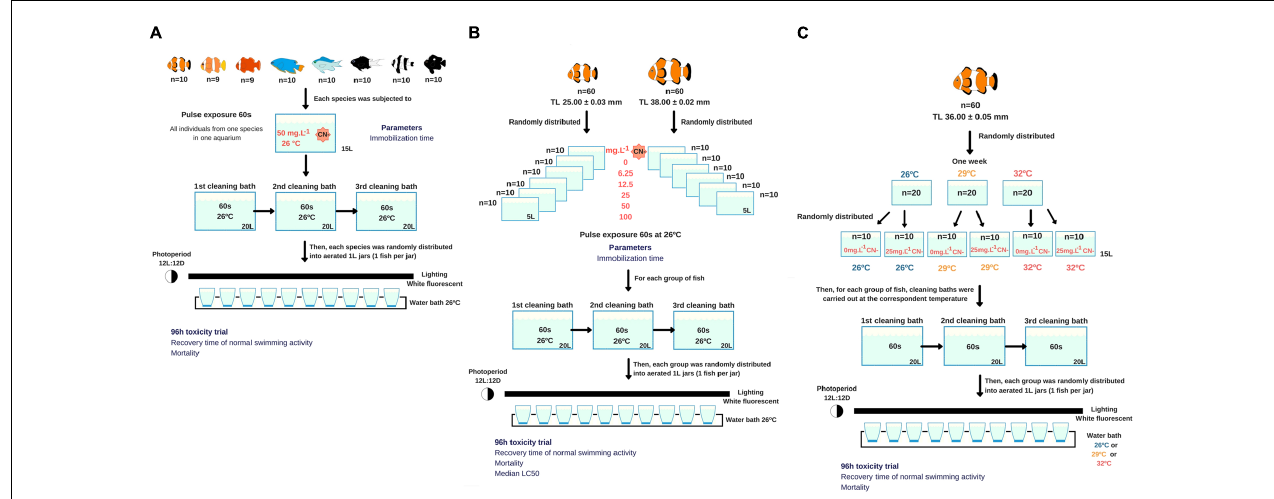
FIGURE 1 | Experimental design. (A) Experiment 1: vulnerability of damselfish to cyanide poisoning. (B) Experiment 2: effects of cyanide on different sized clownfish, Amphiprion ocellaris . (C) Experiment 3: synergistic effect of ocean warming and cyanide poisoning on the physiology of the clownfish, Amphiprion ocellaris . Fish sizes and weights in experiment 1 were (1) Amphiprion ocellaris ( n = 10; total length TL ≈ 40.00 ± 0.02 mm, weight 1.57 ± 0.30 g), (2) A. clarkii ( N = 9; TL ≈ 35.00 ± 0.01 mm; weight 0.90 ± 0.20 g), (3) A. frenatus ( N = 9; TL ≈ 35.00 ± 0.02 mm; weight 1.11 ± 0.15 g), (4) Chrysiptera cyanea ( n = 10; TL ≈ 45.00 ± 0.01 mm; weight 1.57 ± 0.17 g), (5) Chromis viridis ( n = 10; TL ≈ 30.00 ± 0.01 mm; weight 0.50 ± 0.05 g), (6) C. margaritifer ( n = 10; TL ≈ 45.00 ± 0.02 mm; weight 1.58 ± 0.30 g), (7) Dascyllus melanurus ( n = 10; TL ≈ 39.00 ± 0.036 mm; weight 1.54 ± 0.34 g), (8) D. trimaculatus ( n = 10; TL ≈ 41.70 ± 0.03 mm; weight 2.17 ± 0.40